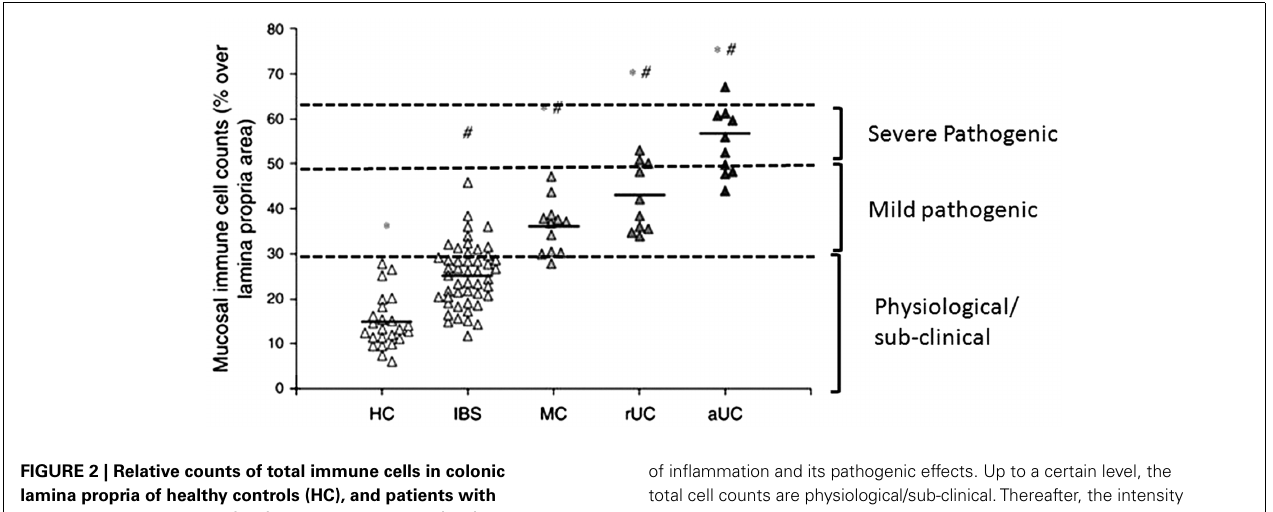
FIGURE 2 | Relative counts of total immune cells in colonic lamina propria of healthy controls (HC), and patients with irritable bowel syndrome (IBS), microscopic colitis (MC), ulcerative colitis in remission (rUC), and active ulcerative colitis (aUC). The total cell counts increase almost linearly with the severity